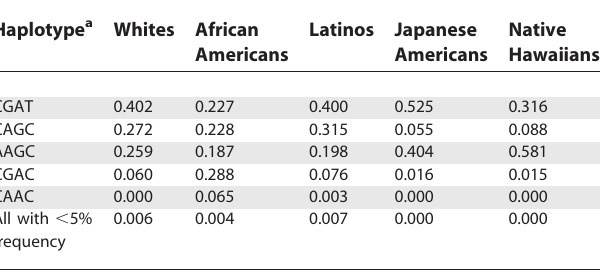
Table 3. Haplotype Frequencies in Controls, by Ethnicity Haplotype a Whites